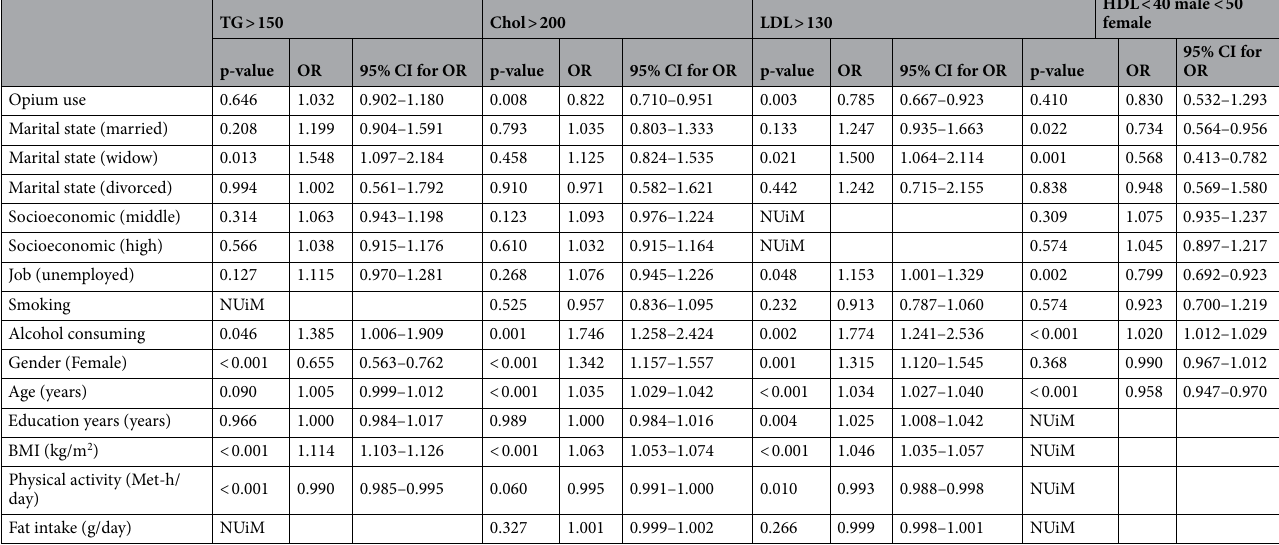
Table 2. logistic regression model for lipid profile in first phase of PERSIAN cohort